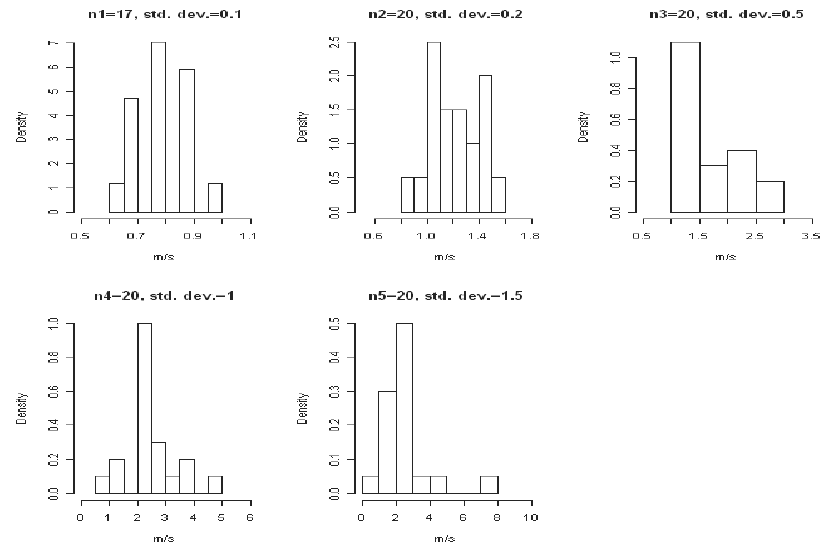
Figure 2 – Sampling histograms of ARFI repeated measurements for five patients by several sample standard